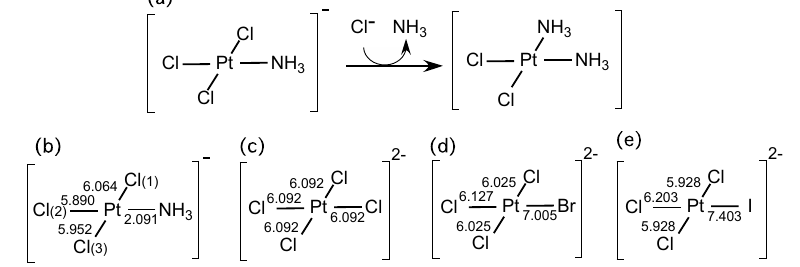
Figure 4. ( a ) The substitution reaction step to yield cisplatin. Calculated LRF-BO values for ( b ) [Pt(NH 3 )Cl 3 ] − ; ( c ) [PtCl 4 ] 2 − ; ( d ) [PtBrCl 3 ] 2 − ; and ( e ) [PtBrCl 3 ] 2 − .